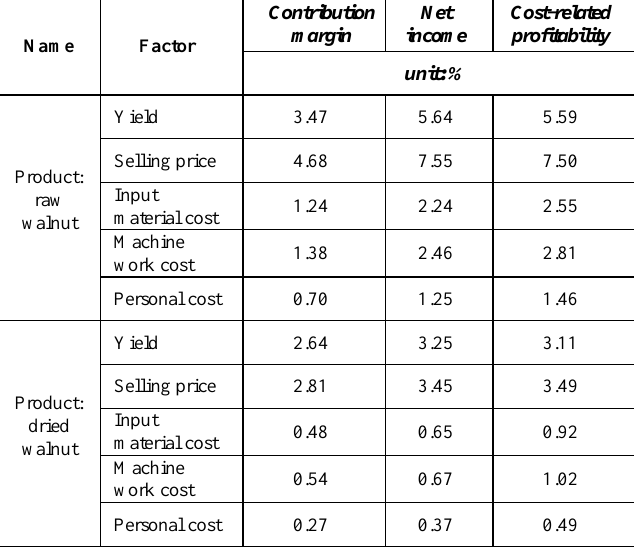
Table 5. Elasticity values of main factors affecting income and